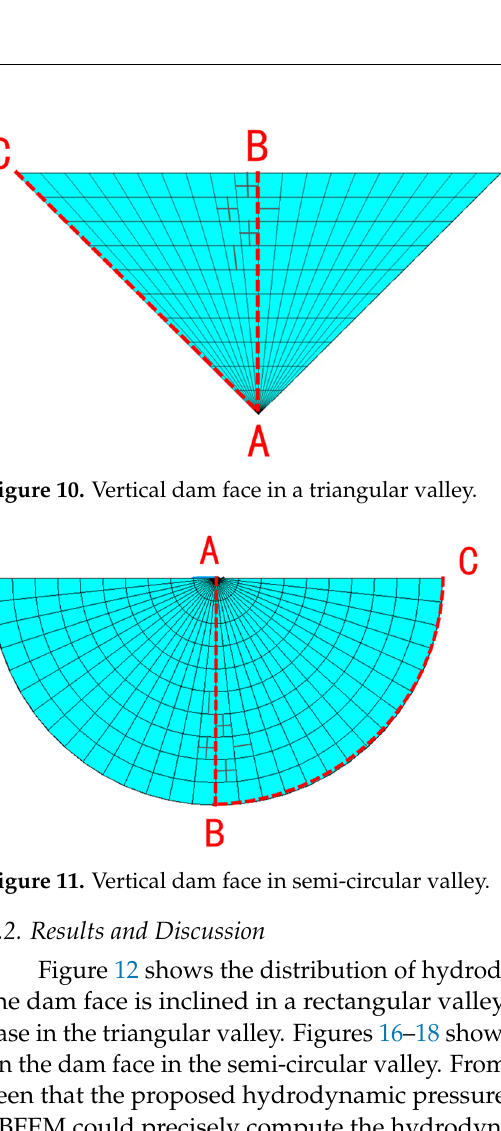
Figure 11. Vertical dam face in semi-circular valley.